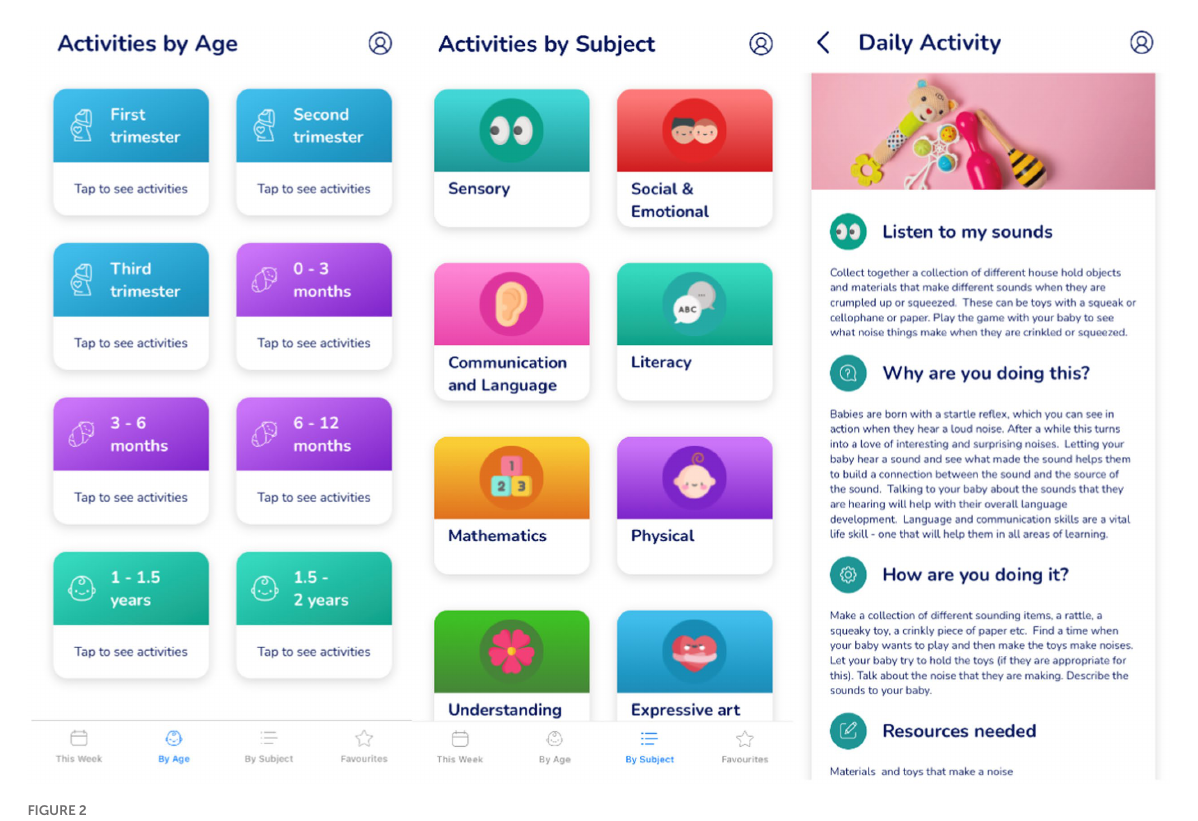
FIGURE 2 Example screenshots taken from the new parenting app intervention (courtesy of